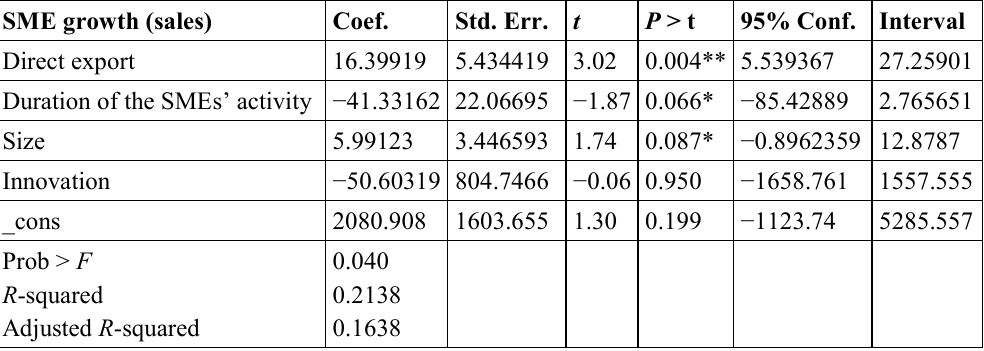
Table 4. Results of Multiple Regression Analysis (ordinary least